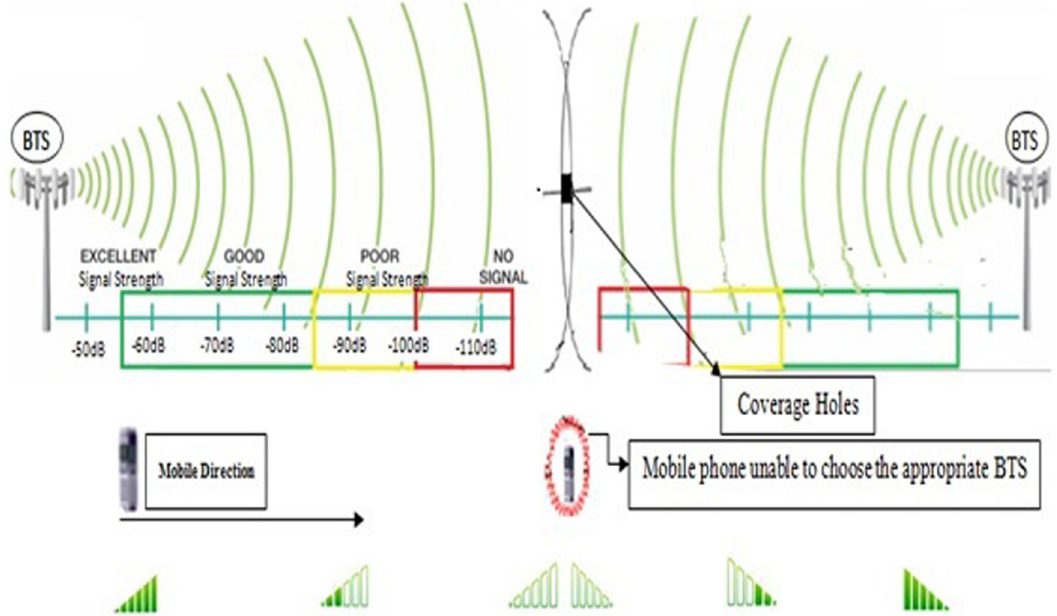
Figure 1: Problem statement and